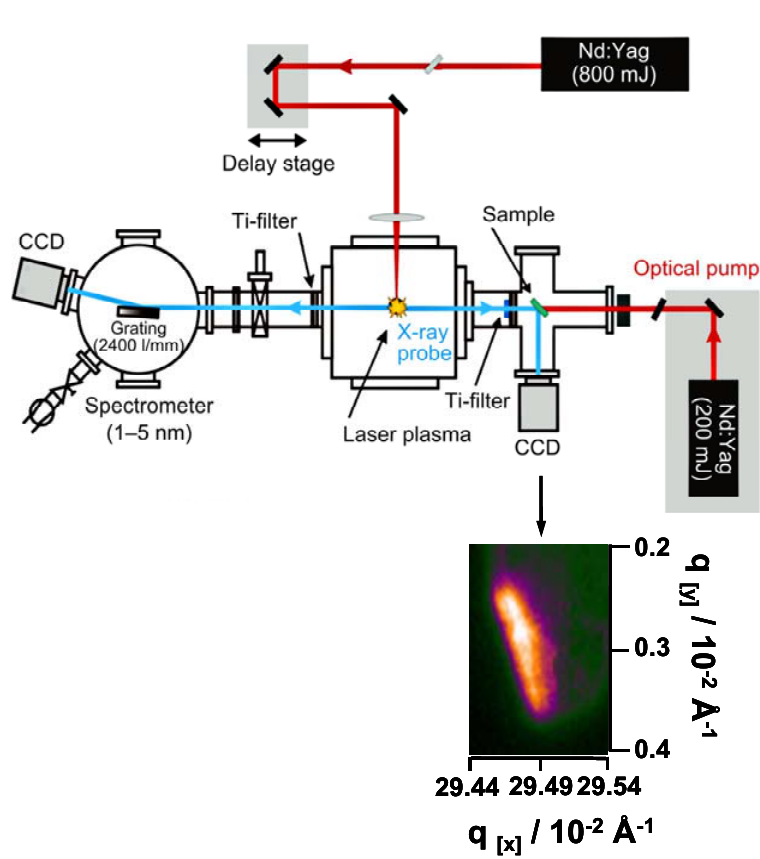
Figure 4. Experimental setup for the time-resolved soft X-ray diffraction experiments. The soft X-ray probe pulse is delivered by a laser-driven plasma source. For the time delay a second Nd:YAG laser is electronically synchronized to the X-ray pulse. The diffraction signal-to-noise ratio is enhanced by using a 2 × 2 pixel